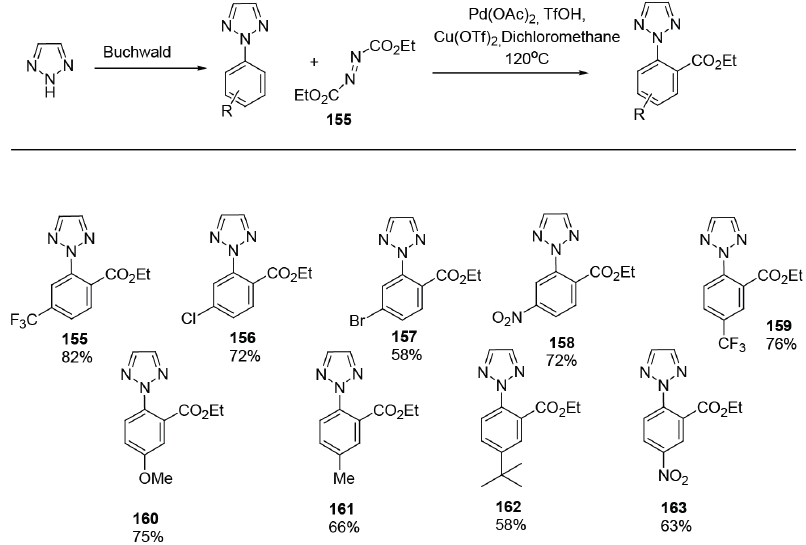
Figure 22 - The Palladium catalyzed C2’ ethoxy carbonylation of the 2-Aryl-1,2,3-triazole.